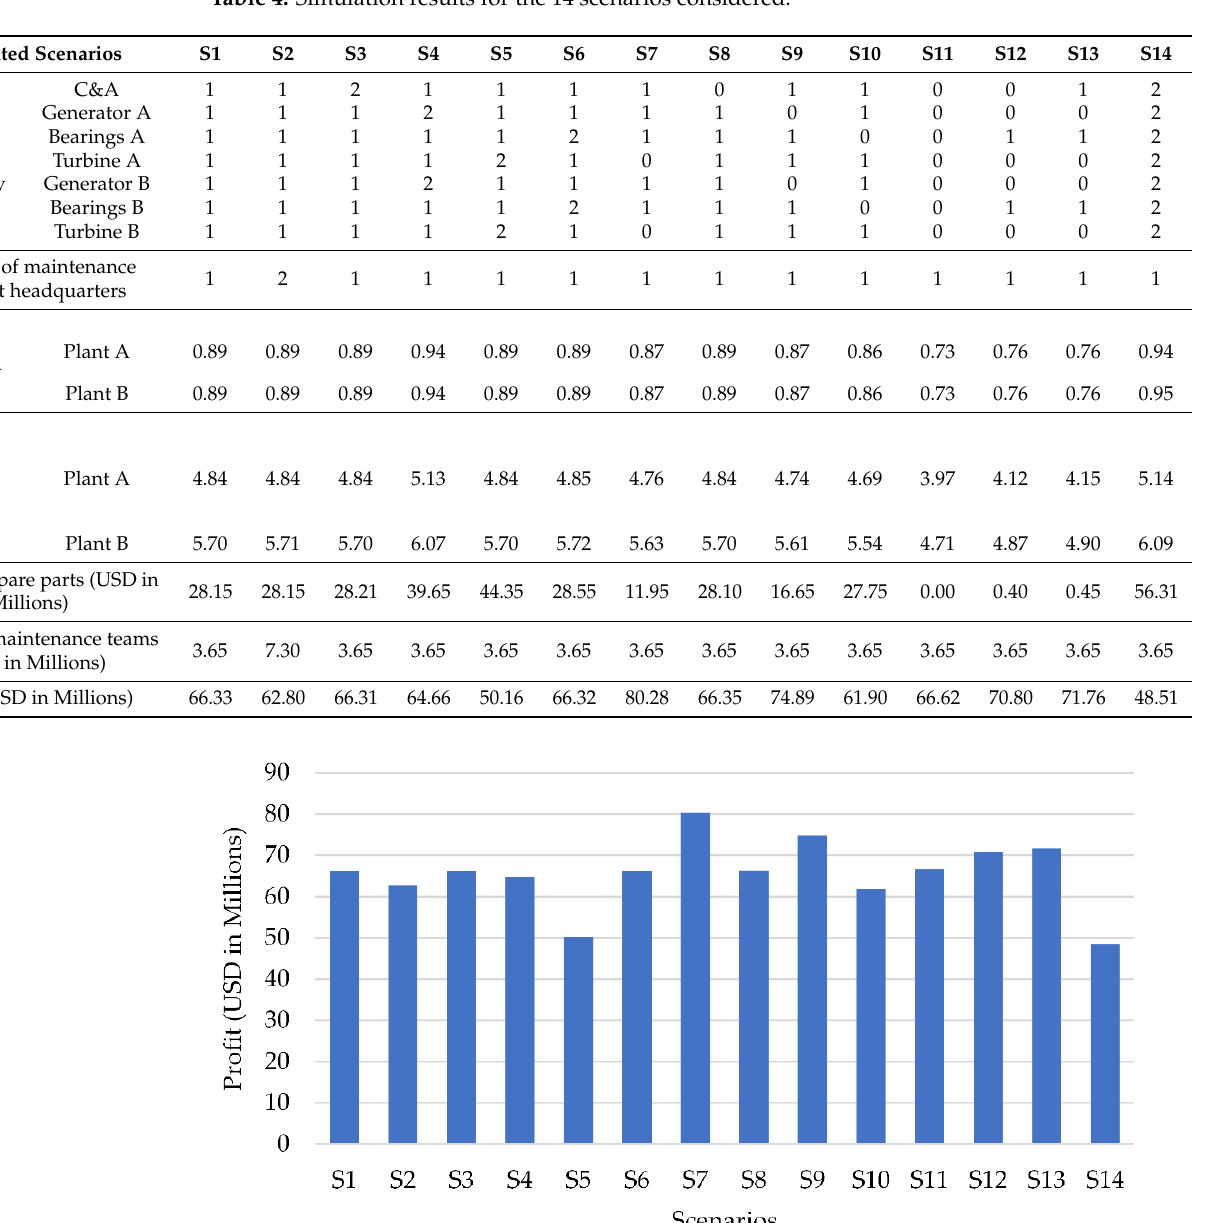
Table 4. Simulation results for the 14 scenarios considered.